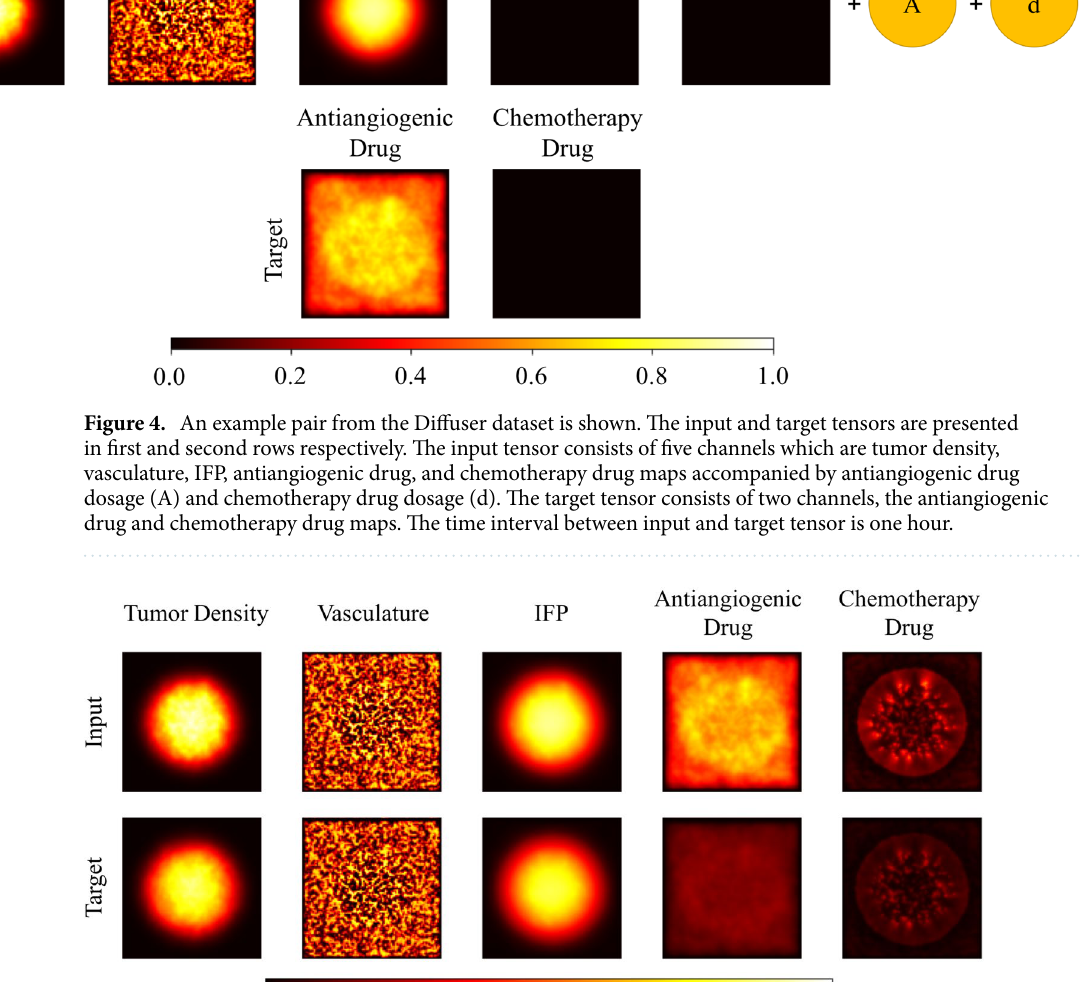
drug dosage value, max ( x ) is the maximum value, and min ( x ) is the minimum value from the corresponding drug. The normalized value of x i corresponds to z i . After scaling, each pixel and scalar input is within the range of [0, 1]. It should be noted that each max ( x ) and min ( x ) value is derived from the training set to ensure that we do not use any information obtained from the test set.